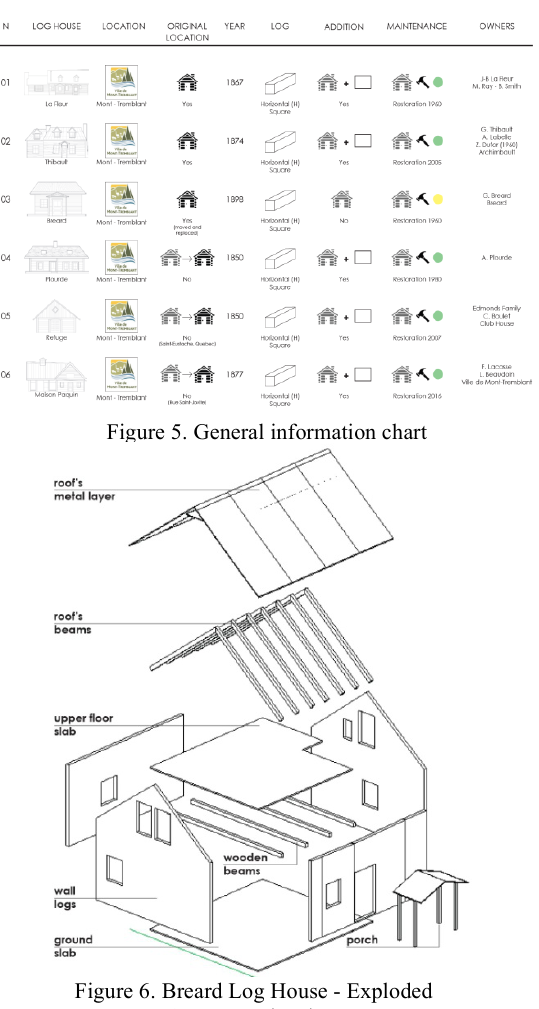
Figure 5. General information chart